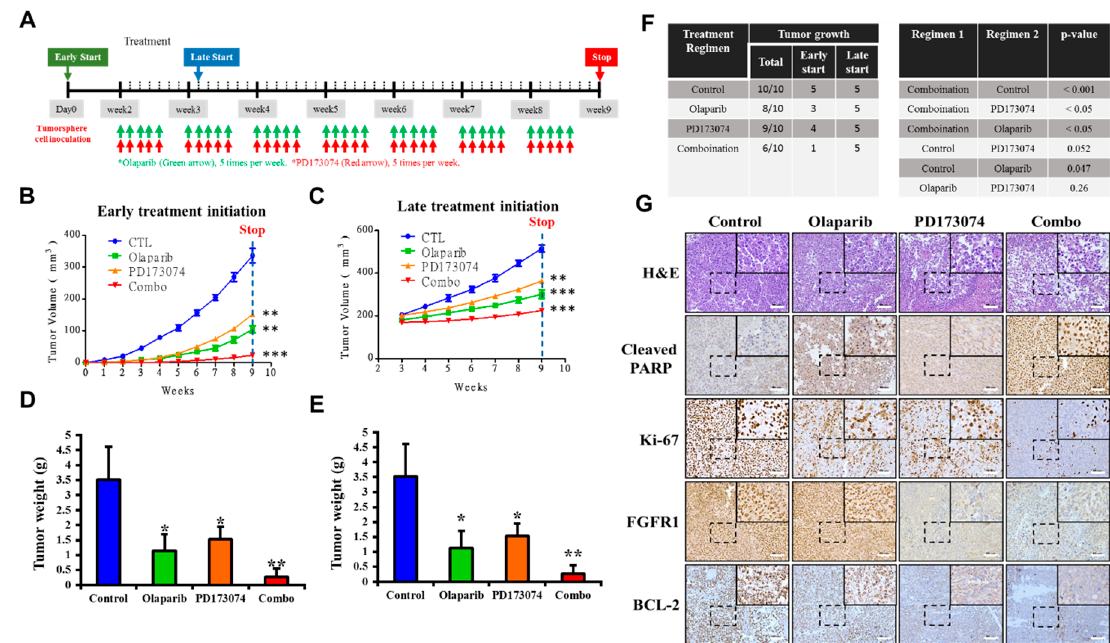
Figure 6. In vivo, PDAC cancer stem cells are more sensitive to PD173074 in the absence of PARP1 . ( A ) Experimental chart of in vivo studies. Line graphs of the di ff erential e ff ect of ( B ) early or ( C ) late initiation of treatment with PD173074 and / or olaparib on BALB / c mice bearing PANC-1 tumorsphere-derived tumors. Graphical representation of tumor weight at the end of the experiment for ( D ) early and ( E ) late treatment initiation groups. ( F ) Frequency of tumor growth and correlative statistical analysis of treatment regimen in the PD173074- and / or olaparib-treated mice. ( G ) Representative immunohistochemical staining images showing di ff erential expression of cleaved PARP, Ki-67, FGFR1, and Bcl-2 in tumors extracted from the PD173074- and / or olaparib-treated NOD / SCID mice. * p < 0.05; ** p < 0.01; *** p <